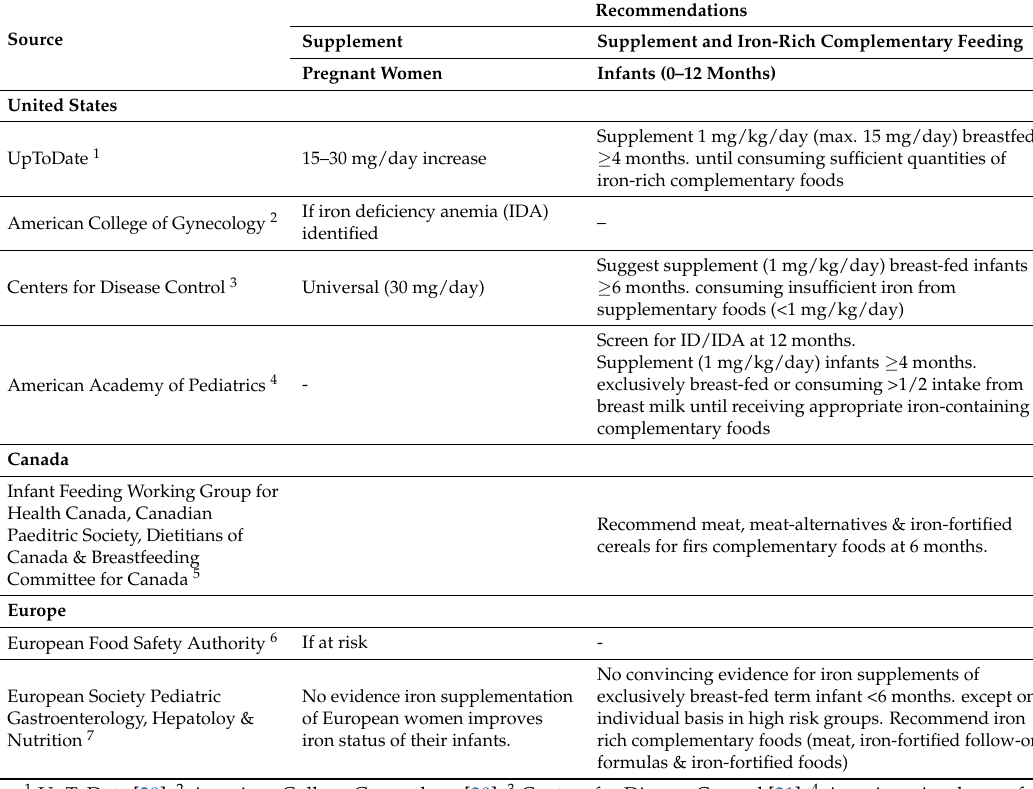
Table 2. Recommendations for Iron Screening, Supplementation and Complementary Feeding of Pregnant Women and Infants in the United States, Canada, Europe, Australia, New Zealand and